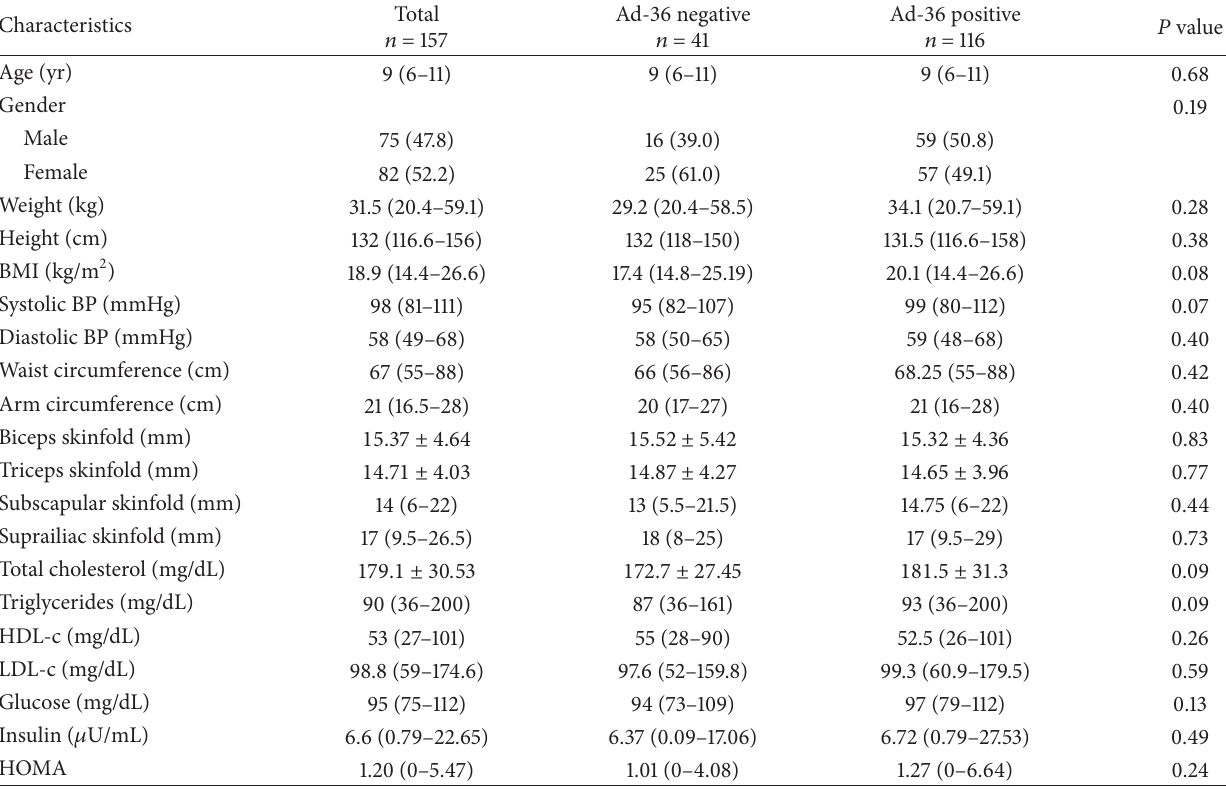
Table 1: Clinical and biochemical characteristics according to Ad-36